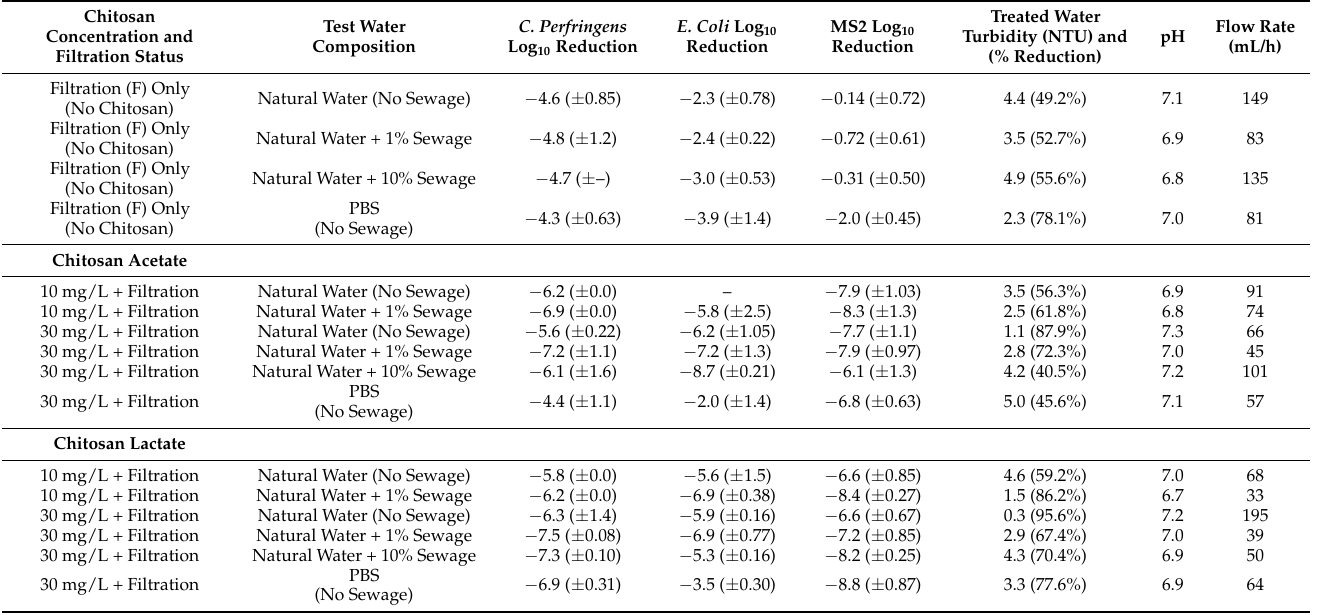
Table 1. Microbial reductions and physical parameters by doses of chitosan acetate and chitosan lactate for each test water. Chitosan Concentration and Filtration